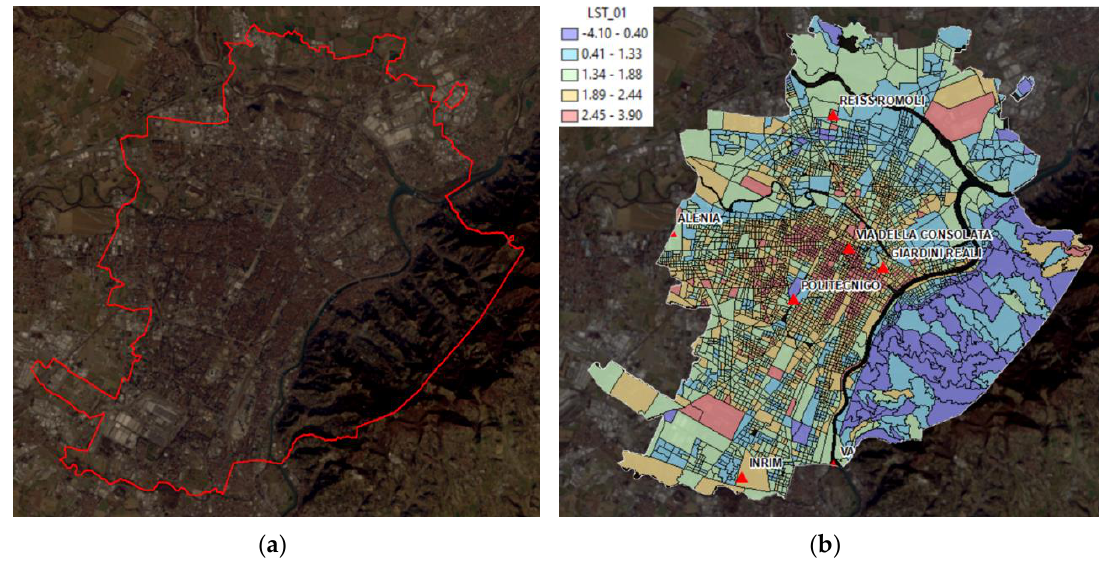
Figure 9. Landsat 8 satellite images: ( a ) referring to 21 January 2016 at 10.17 am; ( b ) LST in °C at a building block scale (the red triangles represent weather stations).